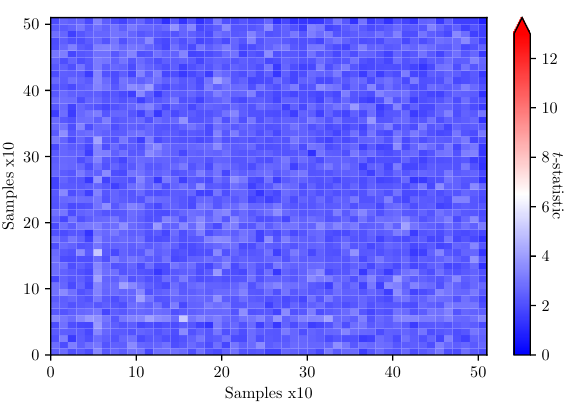
Figure 6: Bivariate second-order t -test for the three-share version with 100 000 traces. The t -statistic shows the absolute